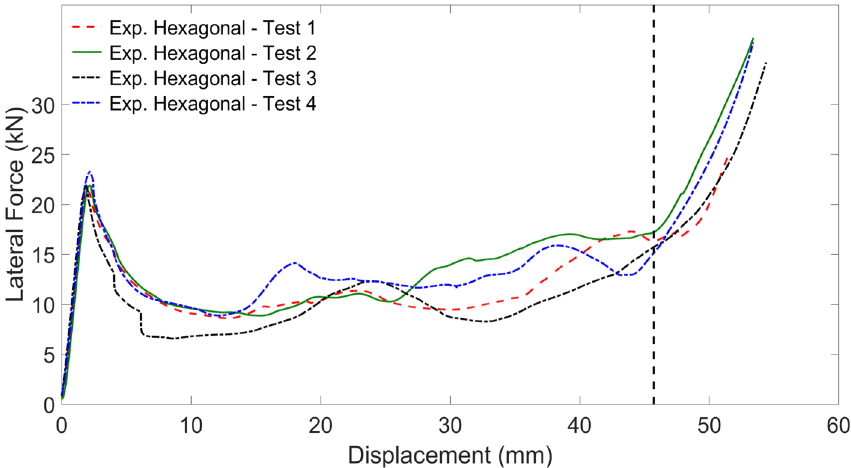
Figure 18. Experimental force-displacement curve of the large-scale specimens constituted by the novel cell geometry and undergoing lateral load.